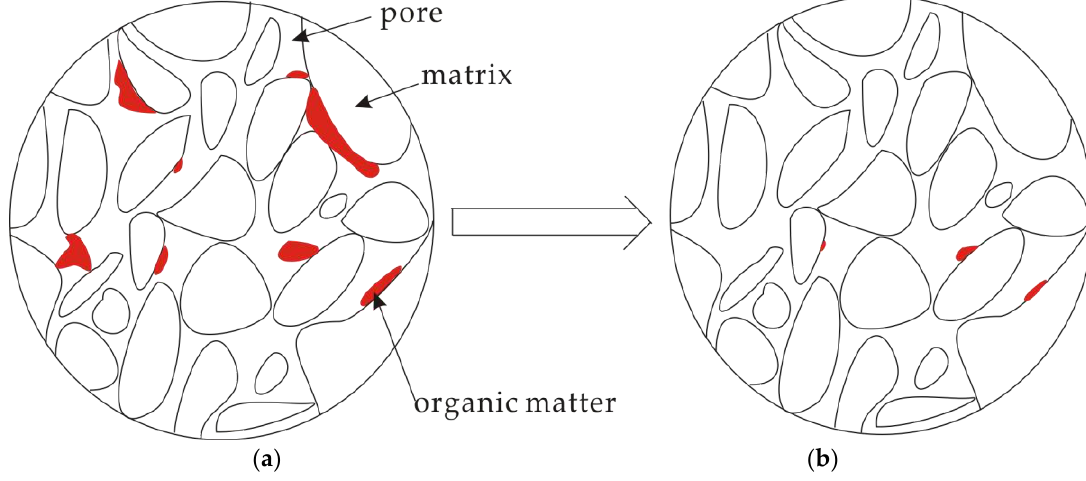
Figure 6. A conceptual mechanism for the evolution of pore structure. ( a ) Pore structure of coal before Sc-CO 2 extraction; ( b ) Pore structure of coal after Sc-CO 2 extraction.